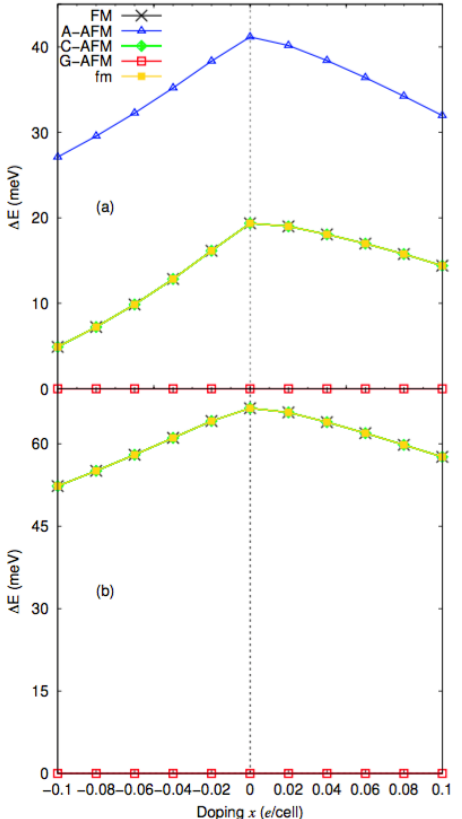
Fig. 7. Total energy difference ∆E with respect to the ground state of bilayer 6-ZGNR (a) and 14-ZGNR (b) at thickness d = 4.35 A˚ as a Fig. 5. Total energy difference ∆ E with respect to the ground state of function of doping x bilayer 6-ZGNR (a) and 14-ZGNR (b) at thickness d = 2 . 35 A˚ as a function of doping x In the bilayer ZGNR, the physical properties were determined by the magnetic couplings at the intraplane- and interplane-edge atoms. At d = 2 . 35 A˚ in figure 5, since the G- AFM state was only the magnetic ground state for all the doping and N , the AFM couplings at both the intraplane and interplane- edge atoms maintain as |𝑥| increased. Thus,